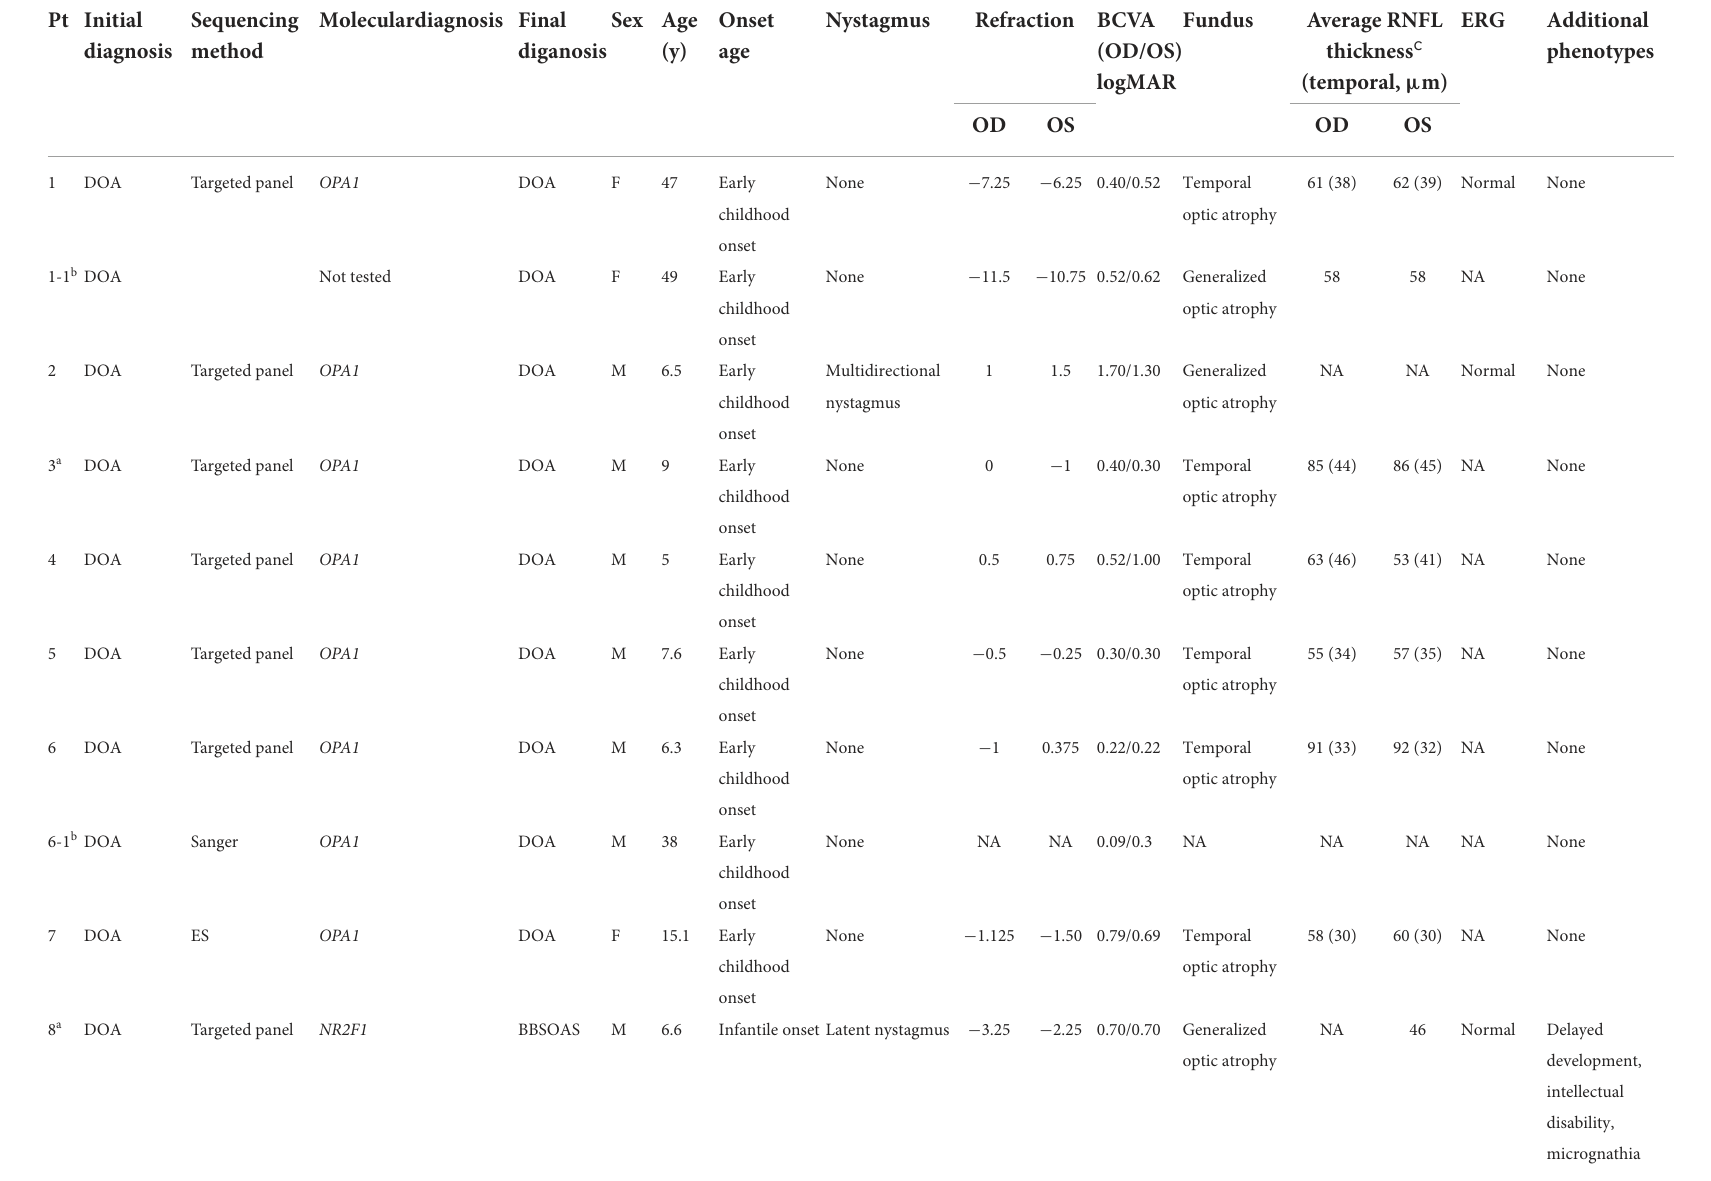
TABLE 1 The clinical features of 18 patients with hereditary optic atrophy and their